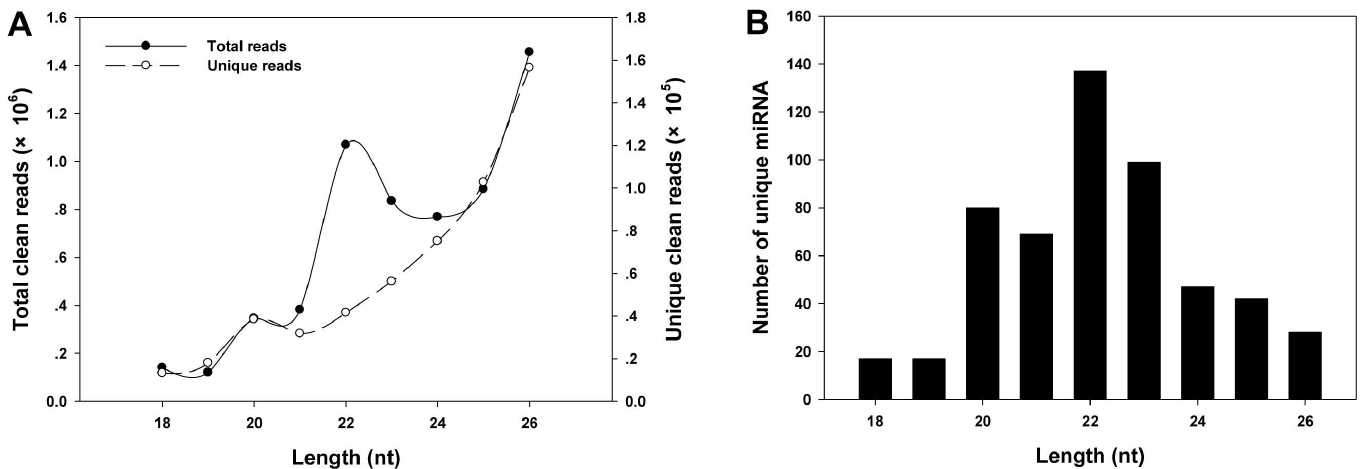
Fig 1. Length distribution of sRNAs in the sRNA library of G . molesta . A , The total numberof clean and uniquereads of sRNAs in lengths of 18–26 nt; B , the numberof uniquemiRNAs rangingfrom 18–26